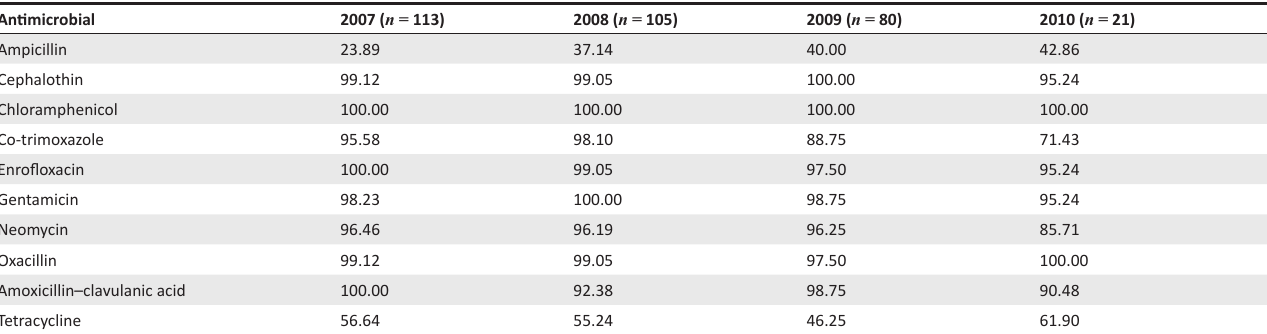
FIGURE 1: Percentage antimicrobial susceptibility of Staphylococcus intermedius isolates from canine skin samples for the period 2007–2010. Antimicrobial